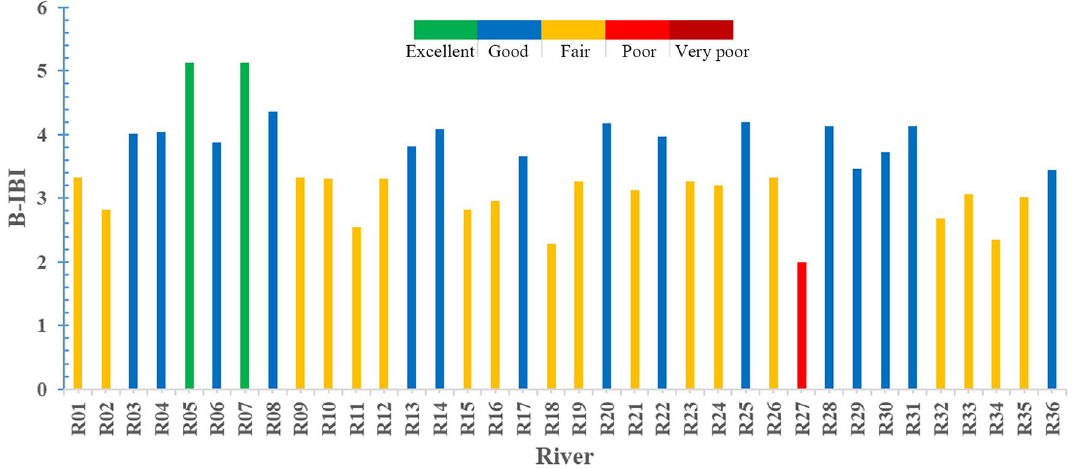
Figure 2. Schematic diagram of health assessment results for 36 important tributaries of